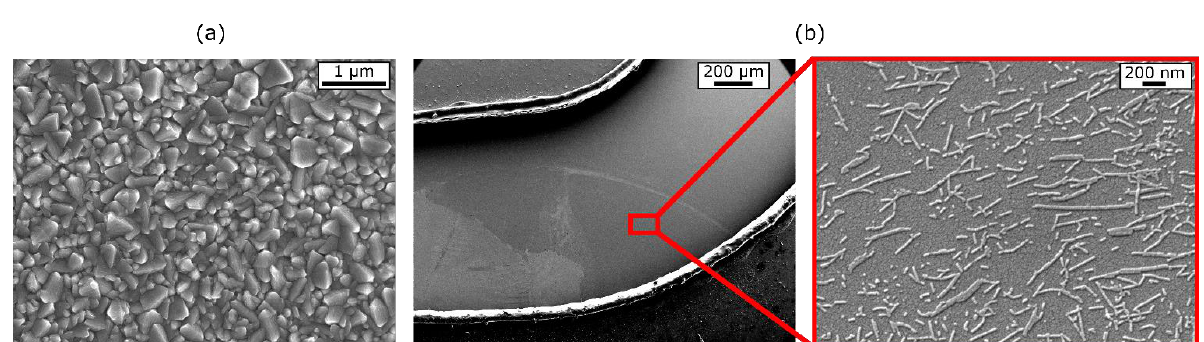
Figure 2. ( a ) Scanning electron microscope (SEM) image (magnification of 20,000× of the LAE showing the TiO 2 film surface on the SnO 2 :F glass substrate. ( b ) SEM image depicting the part of the microfluidic channel where the enzyme-modified Si 3 N 4 surface of the LAPS is located with a magnification of 60× (left) and with a zoom-in, showing the adsorbed TMV particles carrying the immobilized penicillinase with a magnification of 35,000× (right).